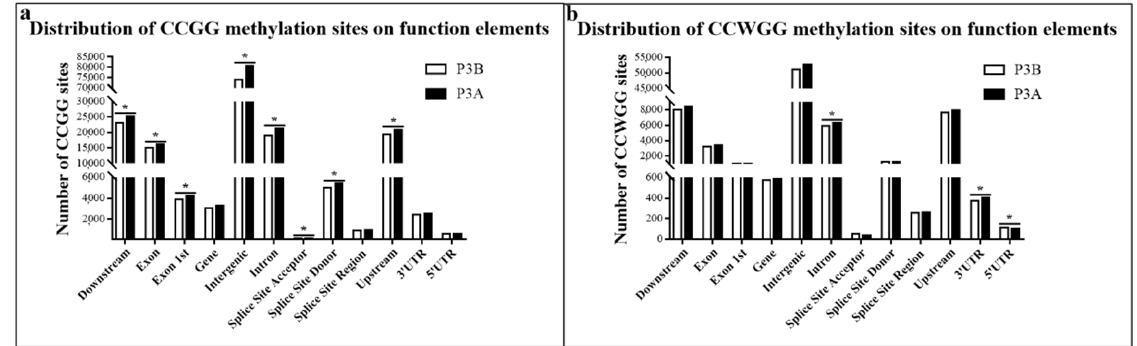
Figure 2. Distribution of methylation sites in different functional elements. ( a ) CCGG sites; ( b ) CCWGG sites. Note: The asterisk indicates significant differences at the p < 0.05 level.